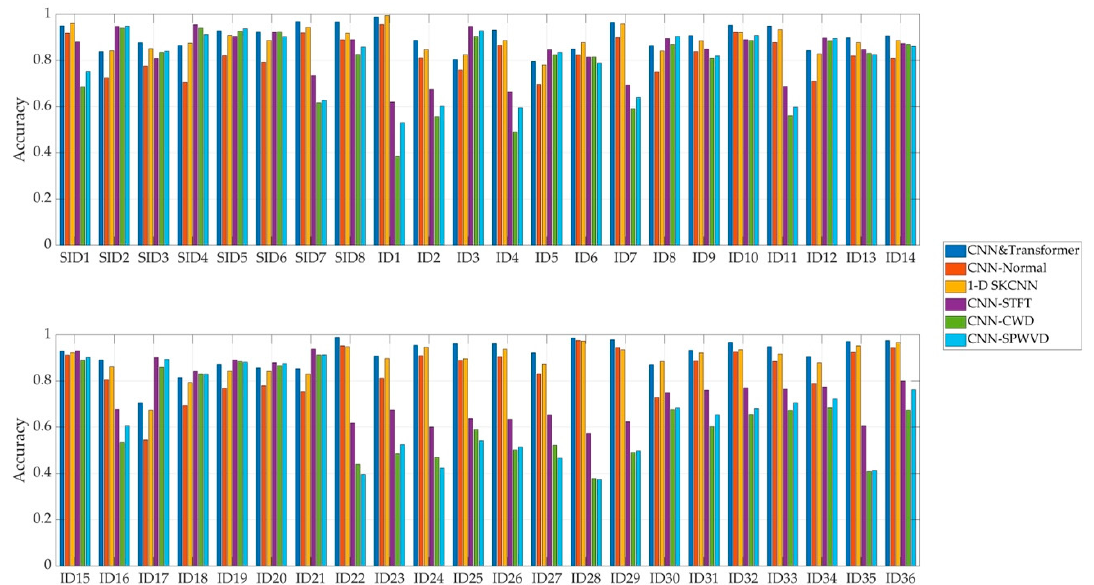
Figure 7. The average classification accuracy of eight single-component and thirty-six dual- component intra-pulse modulation of radar emitter signals based on the mentioned methods.